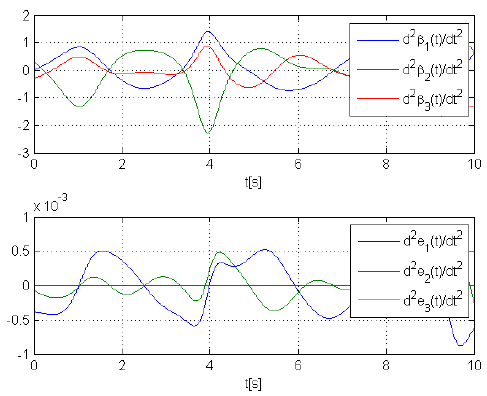
.. β ( t ) obtained by numerically deriving ( ) t   obtained by numerically deriving ( ), t  ( ) t   obtained by numerically deriving ( ), t  ( ) t   obtained by numerically deriving ( ), t 